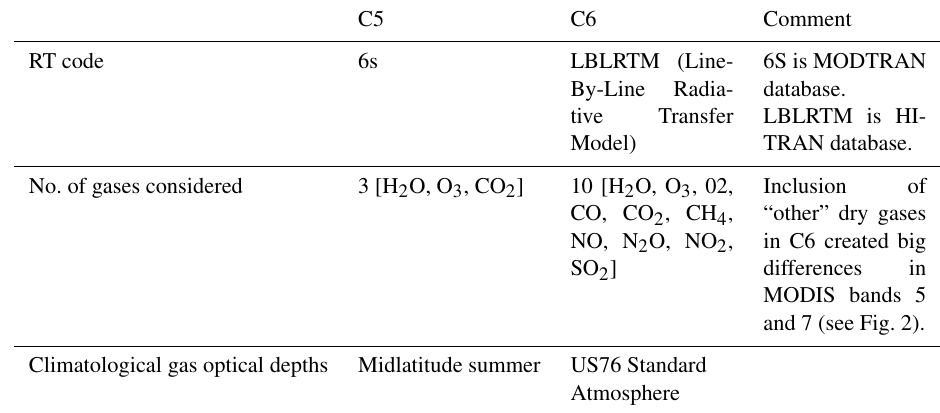
Table 6. Atmosphere gas correction table differences: C5 vs.